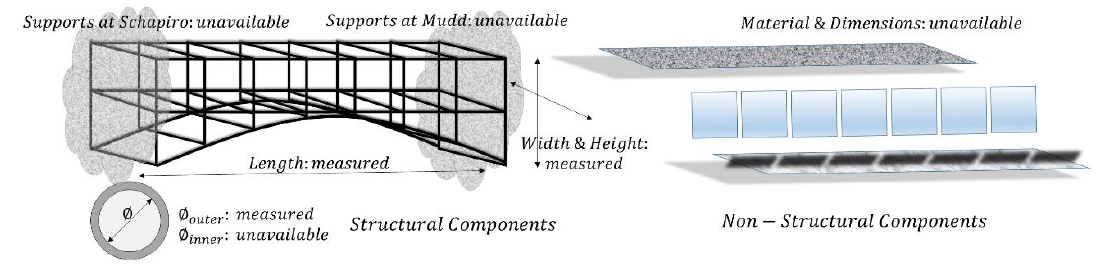
Figure 5. Finite element model nodes, elements and axes.